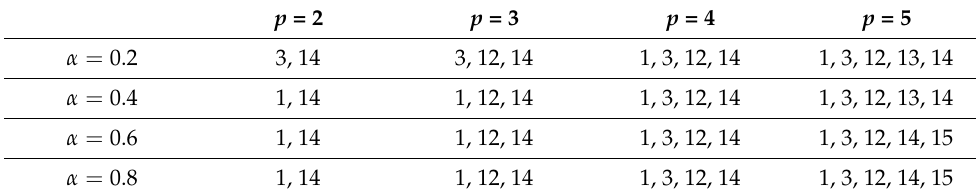
Table 5. Optimal results for different numbers of international gateways. p = 2 p = 3 p = 4 p =